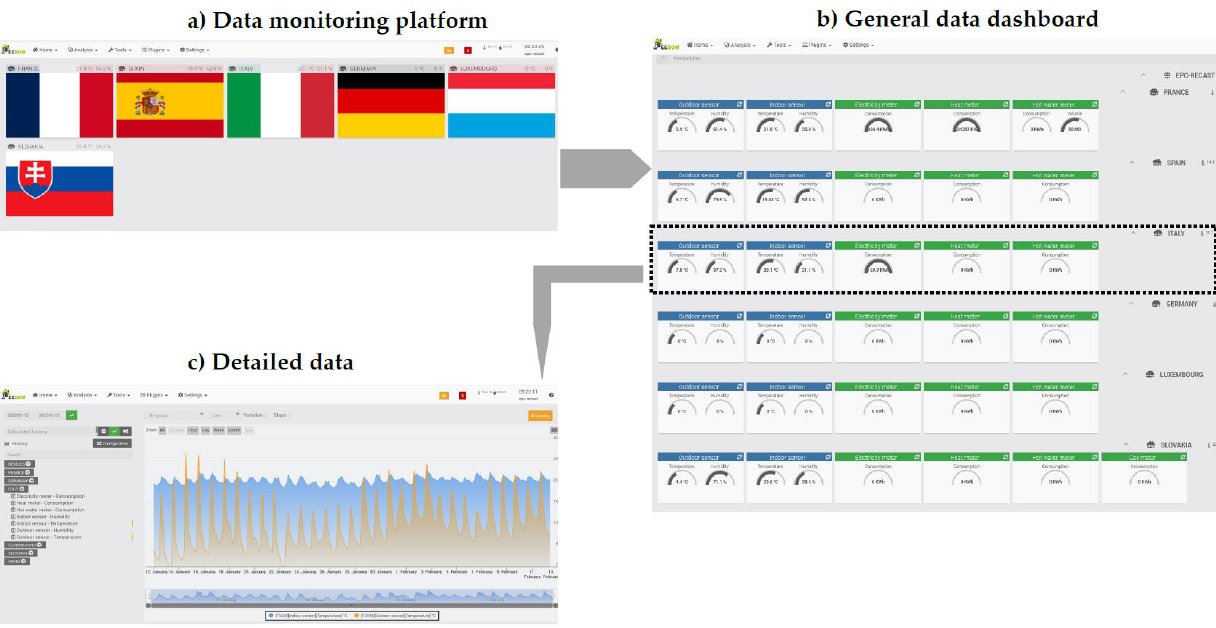
Figure 9. EPC RECAST Long Term Monitoring platform: ( a ) EPC RECAST home page platform; ( b ) general data monitoring dashboard; ( c ) detailed building data monitoring.